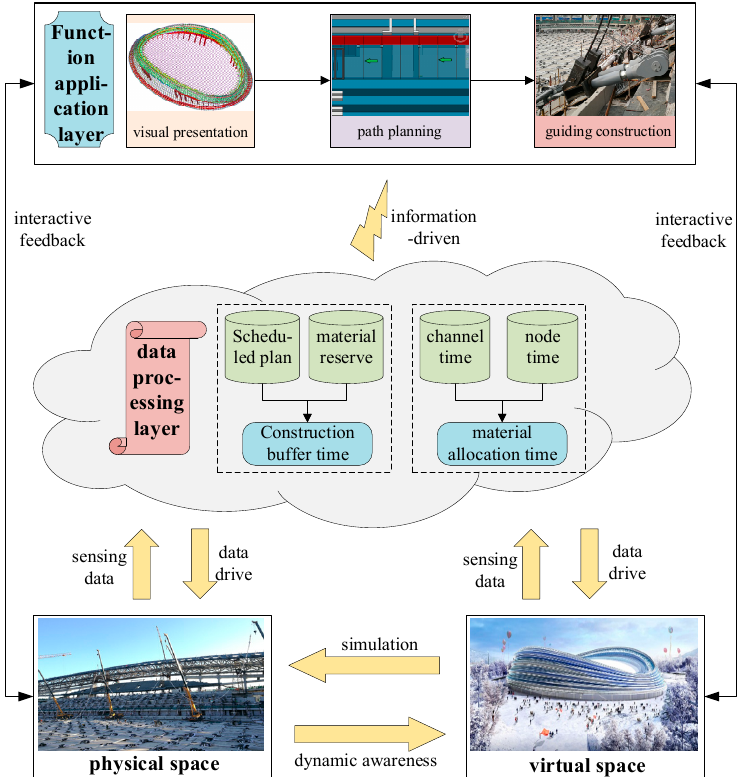
Figure 1. DT framework for intelligent planning of construction-material-allocation path.